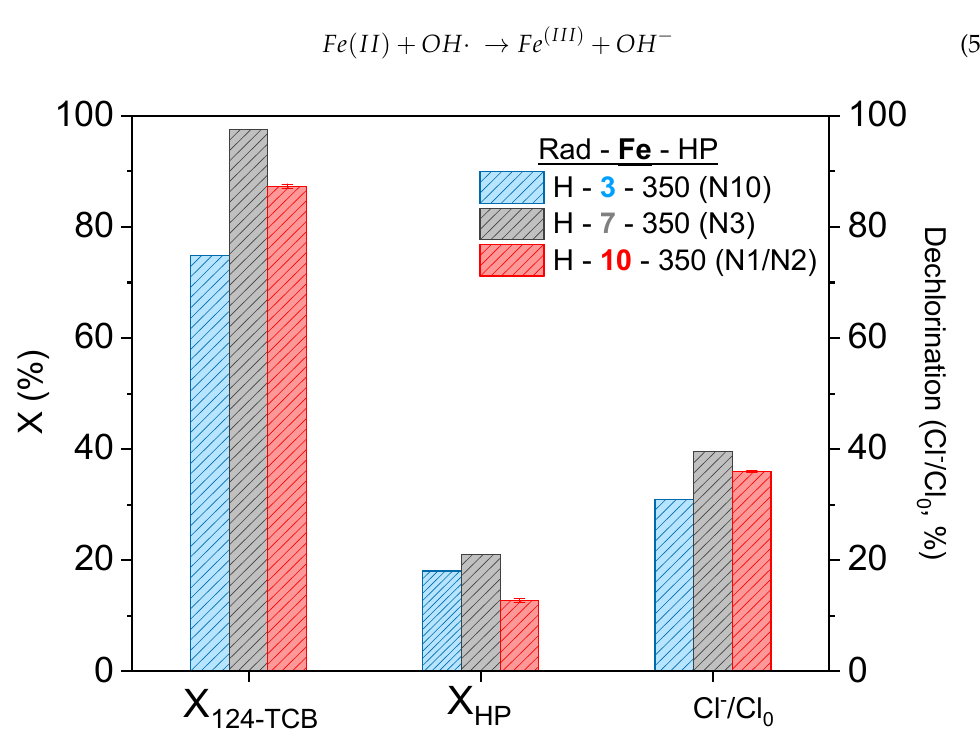
Figure 2. Effect of catalyst concentration on the conversion of 124-TCB and HP and the dechlori- nation degree achieved after 180 min of reaction. Experimental conditions: H 2 O 2 = 350 mg L − 1 , 124-TCB = 28 mg L − 1 , and High rad intensity (H).